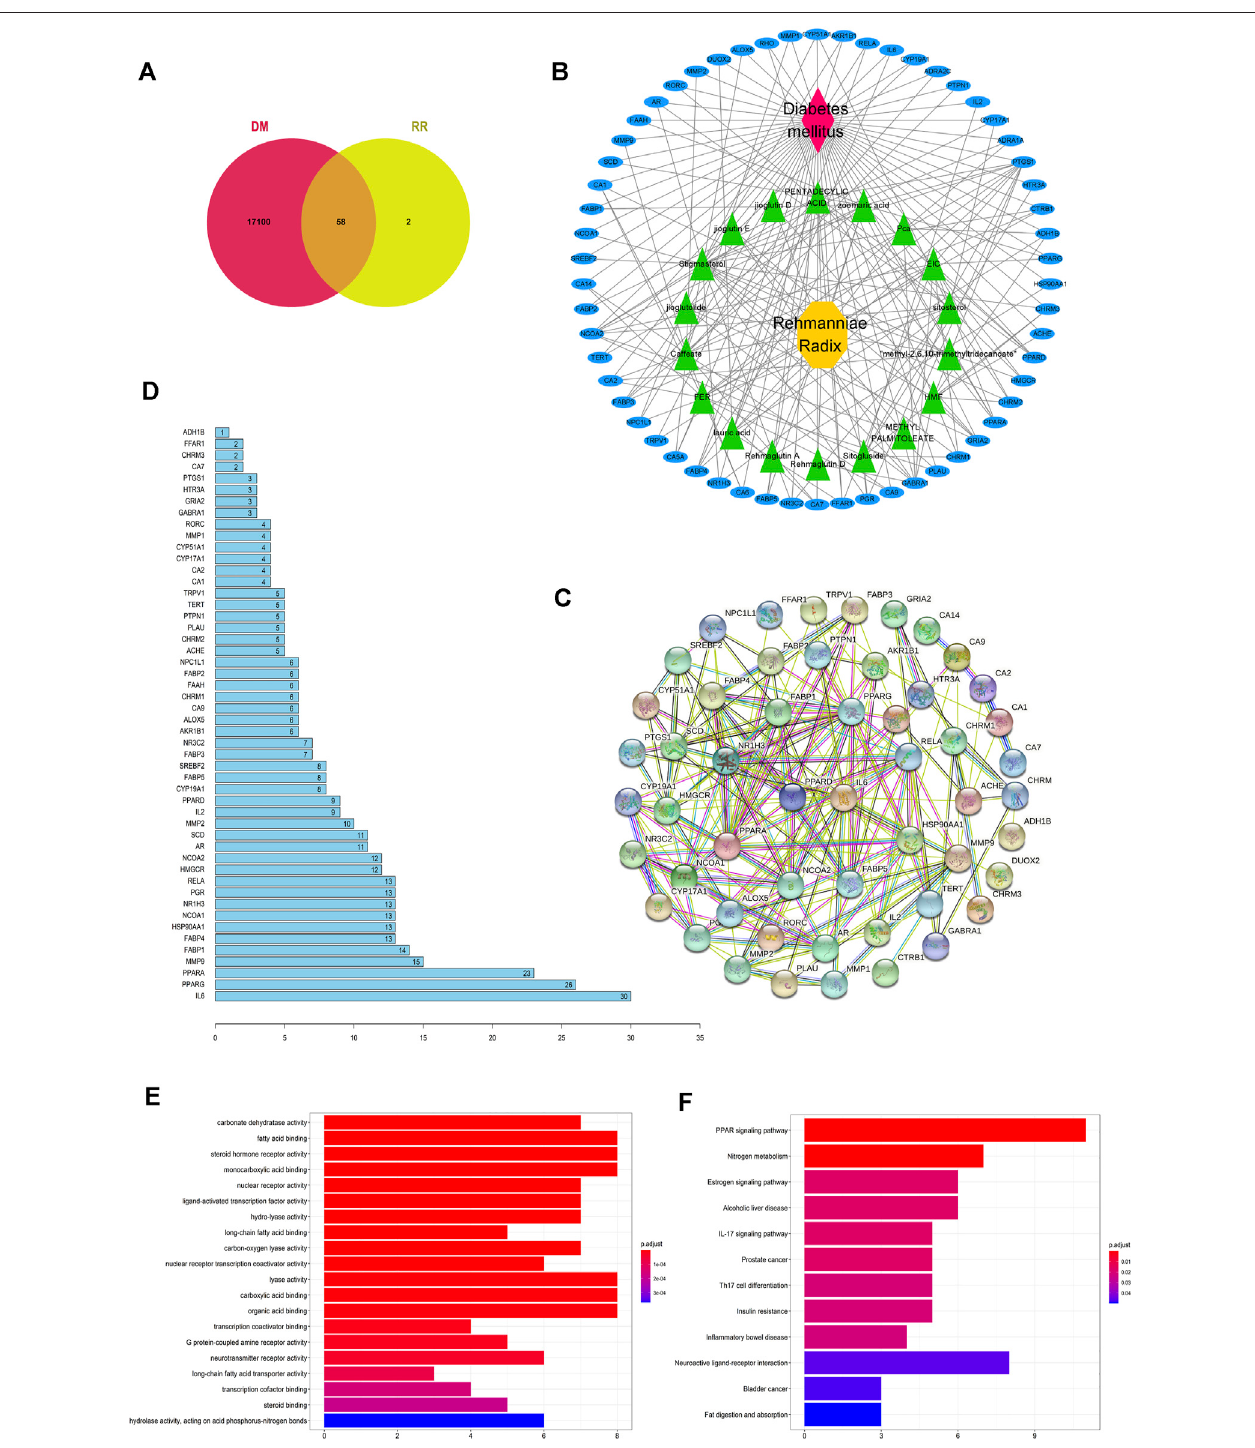
FIGURE2| PotentialantidiabetictargetsofRRwerepredictedbynetworkpharmacology. (A) VenndiagramoftheintersectionofthetargetsbetweenRRandDM. (B) RR – components – targets – DMnetwork.Forthenodes, redrepresentsDM,yellowrepresentsRR,green represents componentsofRR,and bluerepresentstargets. Edges represent interactions. (C) Diagram of the protein – protein interaction (PPI) network. Each node represents a protein, with the protein structure located in the middle of nodes, and edges represent interactions between nodes. (D) Histogram of the number of adjoining nodes in the PPI network. The number of adjoining nodesforeachgenewascalculatedandismarkedtotherightofthehistogram. (E) HistogramofGOenrichment.Theabscissarepresentsthenumberofgenesenriched in the GO term. The ordinate represents different GO terms, and the color represents the p value. Twenty GO terms with the smallest p value are listed in the histogram. (F) Histogram of KEGG enrichment. The abscissa represents the number of genes enriched in the KEGG pathway. The ordinate represents the different KEGG pathways, and the color represents different p value.